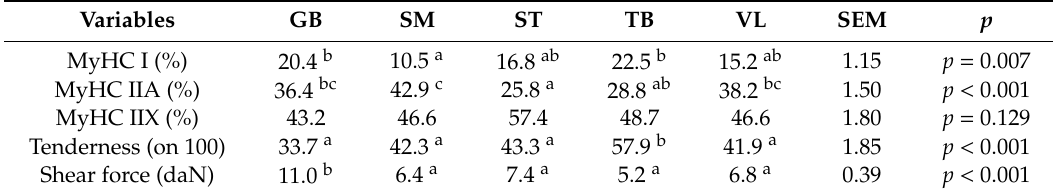
Table 2. Muscular characteristics of the 5